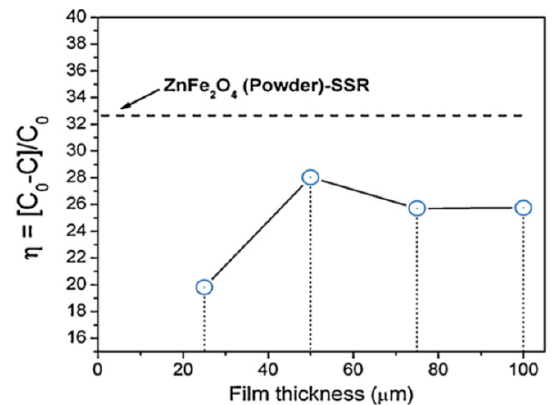
Figure 17. Methylene blue photo de-coloration efficiency versus ZnFe 2 O 4 film thickness for films deposited at precursor pH = 8. The dotted horizontal line represents the efficiency of powder ZnFe 2 O 4 photocatalyst synthesized by a solid state reaction. Reproduced with permission from [10], Elsevier, 2012.